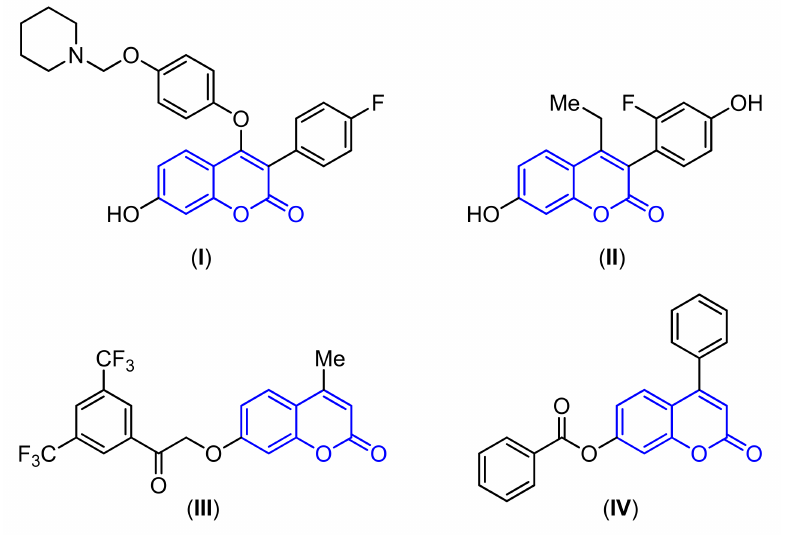
Figure 1. Biologically active 7-hydroxycoumarin